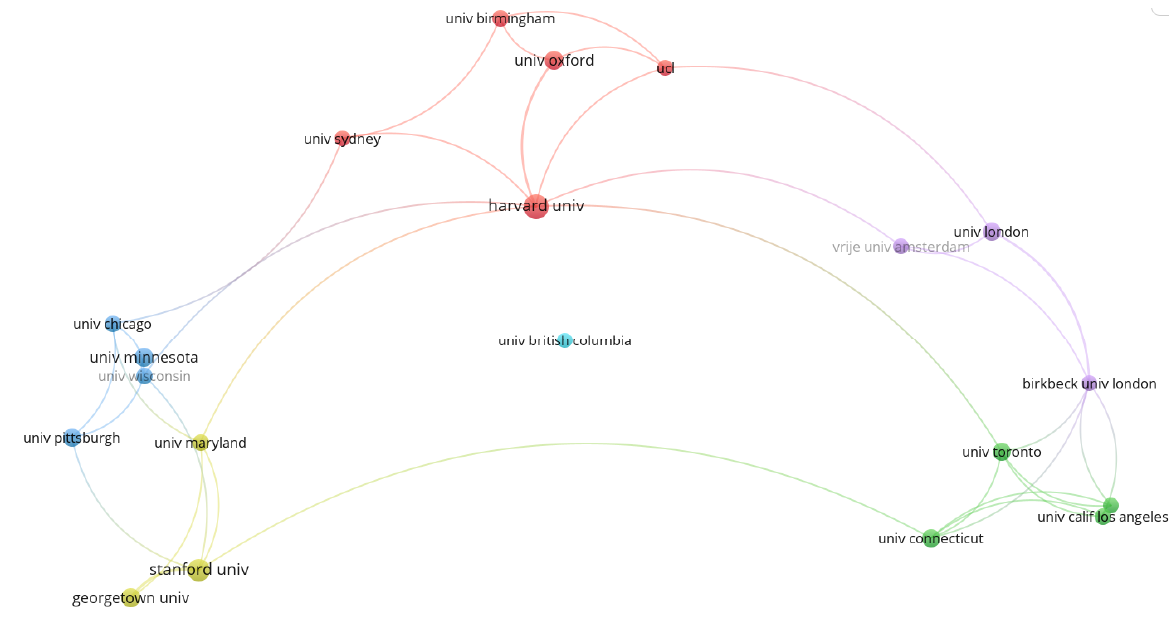
Figure 4. Institutional collaboration network.